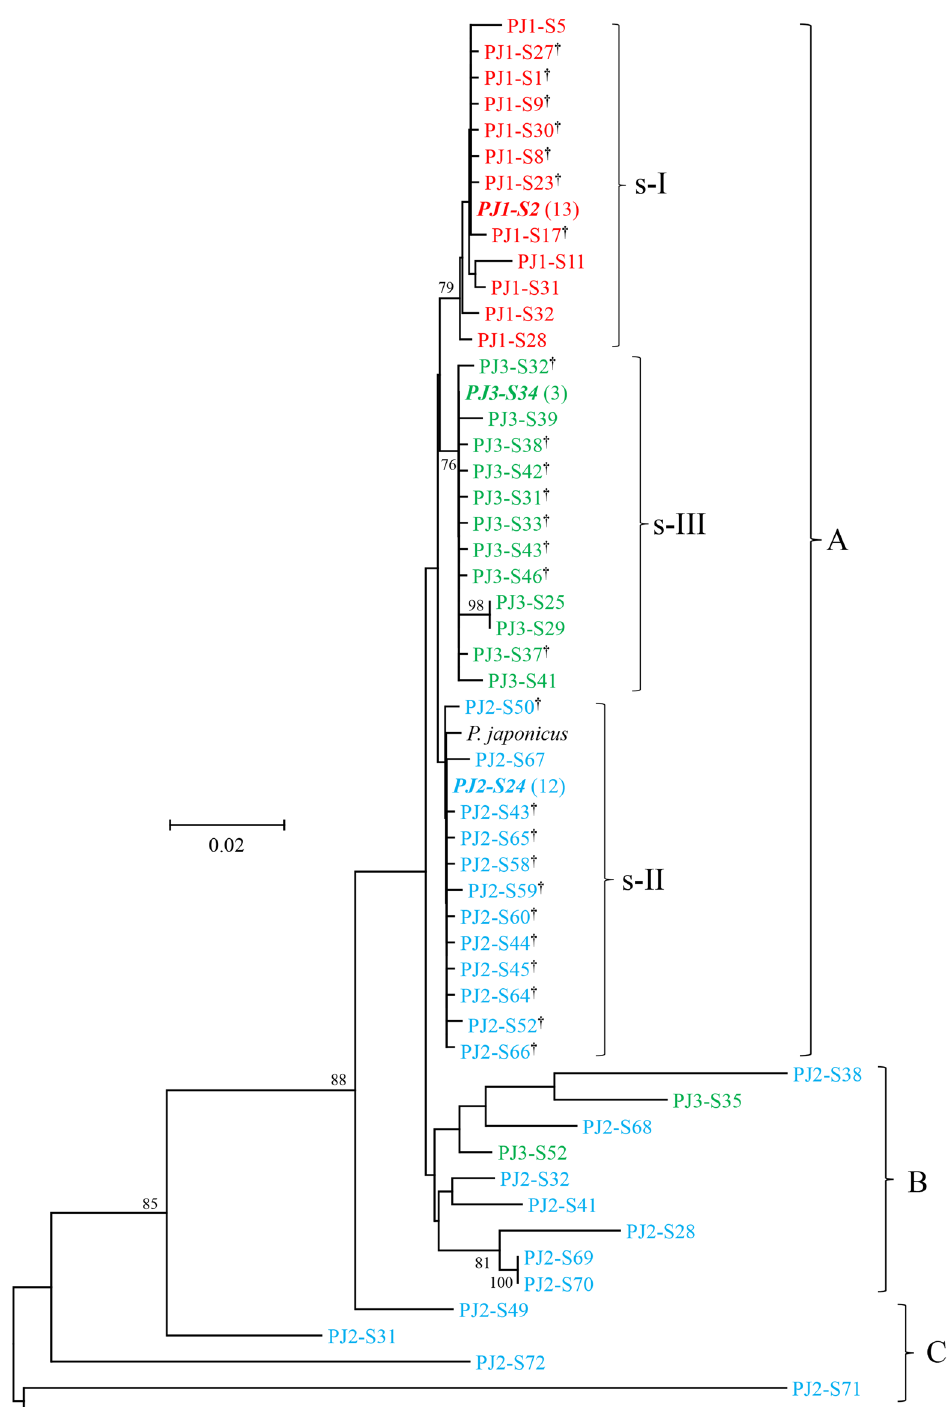
Figure 2. Neighbor-joining phylogenetic (NJ) tree showing relationships among 52 different haplotypes of clones of 12S rDNA (12S) or 12S-like sequences obtained from the Japanese spiny lobster ( Panulirus japonicus ), and 12S rDNA sequences of P. japonicus and P. cygnus derived from the GenBank database. Haplotypes detected from the same lobster individual share the same color. Genuine mtDNA haplotype is shown in bold italic and number of clones examined is shown in parenthesis. Haplotypes carrying dagger differ from corresponding genuine mtDNA haplotype by less than two nucleotides (including indel). The bootstrap values greater than 60% (out of 1000 replicates) are shown at the